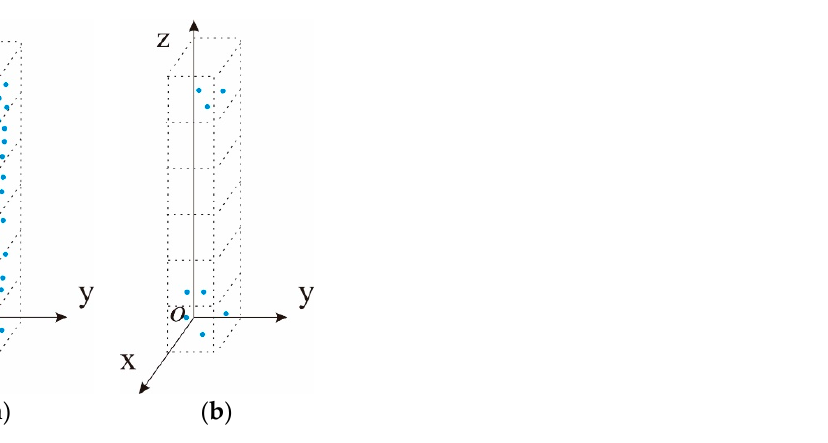
Figure A1. Comparison of continuity in the vertical direction between the trunk points and the misjudged points. ( a ) Trunk points; ( b ) Misjudged points.